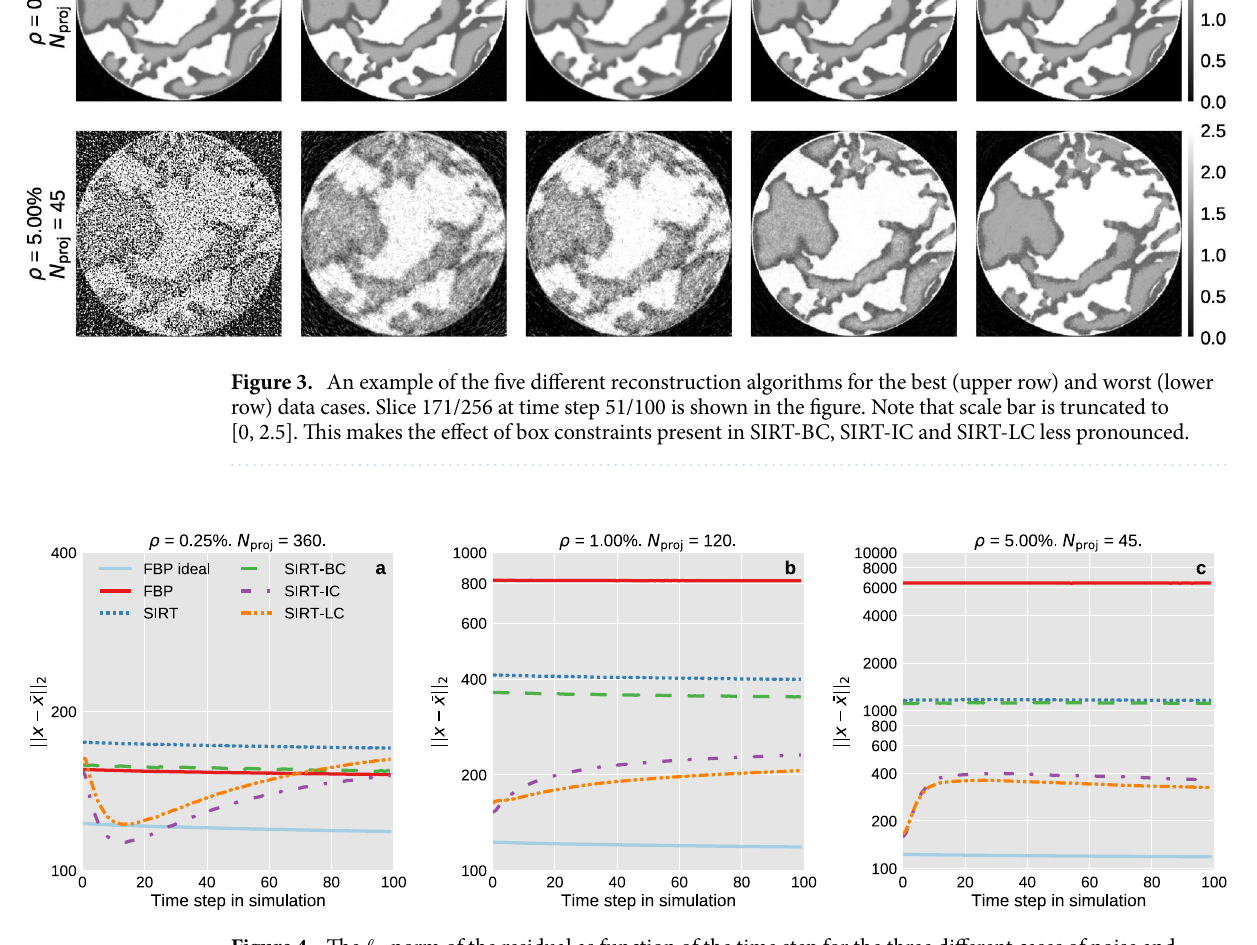
Figure 4. The ℓ 2 -norm of the residual as function of the time step for the three different cases of noise and number of projections. The ideal FBP reconstruction ( ρ = 0.25% , 720 projections) is shown for comparison. Notice that the y-axis range is different on the three